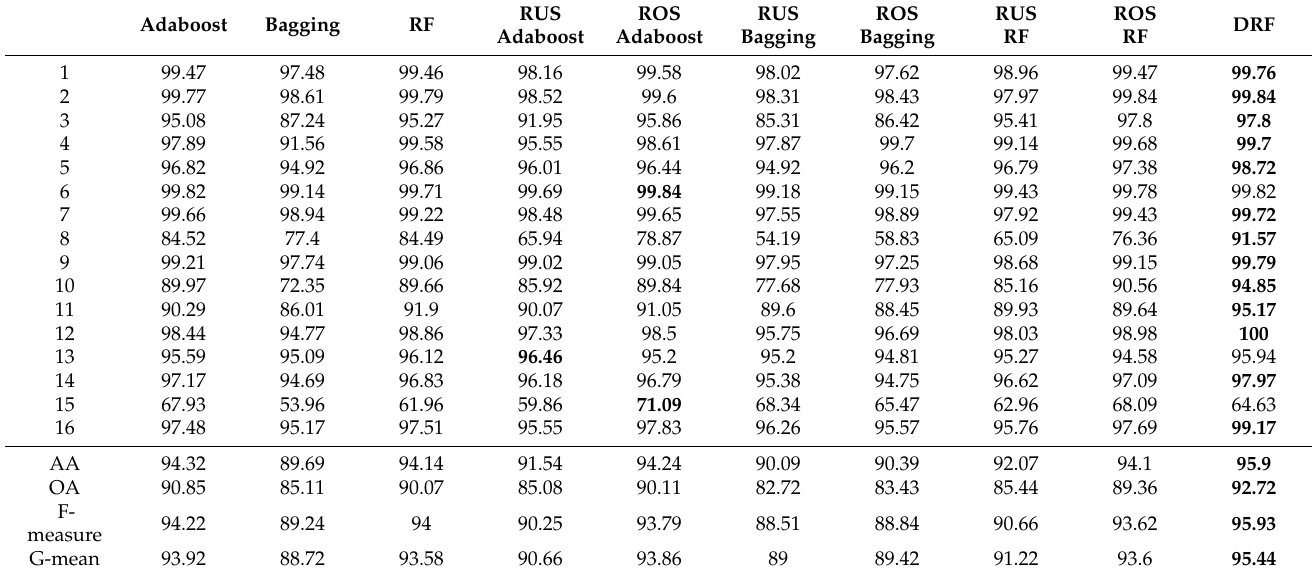
Table 4. Classification results (%) of the Salinas image, respectively, obtained by Adaboost, Bagging, RF, RUS + Adaboost, ROS + Adaboost, RUS + Bagging, ROS + Bagging, RUS-RF, ROS-RF, and the proposed